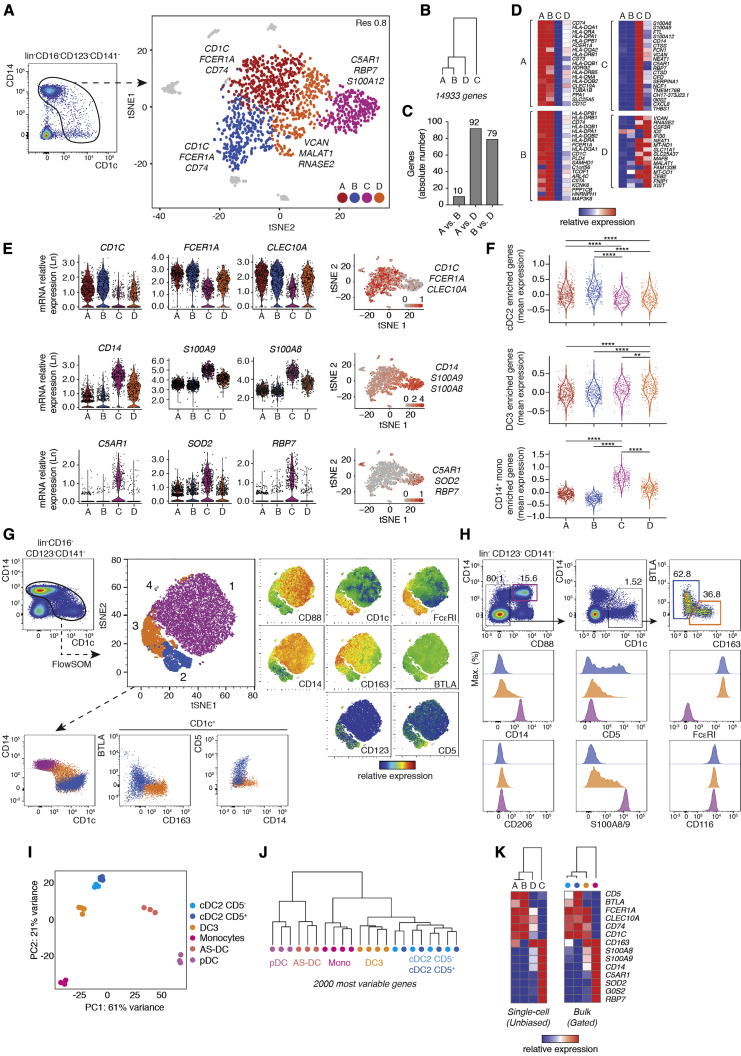
DC3s Are a Discrete Subset of CD88−CD1c+CD163+ Cells in Human Peripheral Blood(A) Gating strategy used to define mononuclear phagocytes expressing CD14 and/or CD1c. Cells expressing CD14 and/or CD1c were sorted by flow cytometry from 3 healthy donors and pooled before scRNA-seq analysis. To improve the resolution of CD1c+ subsets, the cellular input was enriched in CD1high cells (Figure S1A). Single cells were isolated using a droplet-based approach and sequenced. Dimensionality reduction of scRNA-seq data was performed using dimensionality reduction (t-distributed stochastic neighbor embedding [tSNE]). Clusters A, B, C, and D were identified using the shared nearest neighbor (SNN) clustering algorithm. Each dot represents an individual cell (n = 1,622).(B) Hierarchal clustering of groups A, B, C, and D based on average gene expression (14,933 genes).(C) Absolute number of differentially expressed genes (DEGs) for pairwise comparisons between groups A, B, and D.(D) Heatmaps displaying relative expression of up to 20 DEGs defining each cluster.(E) Violin plots illustrating expression probability distributions across clusters of representative DEGs (226 total DEGs). Feature plots display the average expression of groups of genes (identified in violin plots) in each cell of the tSNE plot defined in (A).(F) Expression distribution across clusters A, B, C, and D of gene signatures identified by Villani et al. (2017) and Yin et al. (2017). (∗∗p < 0.01, ∗∗∗∗p < 0.0001, one-way ANOVA test)(G) Identification of 4 subsets within CD14lo to hi CD1clo to hi cells by unsupervised clustering of flow cytometry data using the FlowSOM algorithm. tSNE and unsupervised clustering were performed using the following markers: CD88, CD1c, FcεRI, CD14, CD163, BTLA, CD123, and CD5. tSNE plots (right) display the relative expression of each marker among the subsets. Dot plots (below) show the expression of specific markers in clusters 1, 2, and 3 when combined in 2-dimensional analysis.(H) Improved gating strategy for identification of cDC2s, DC3s, and CD14+ monocytes in circulating PBMCs and histograms showing expression of S100A8/9, FcεRI, CD5, CD14, CD116, and CD206.(I) Principal-component analysis (PCA) for bulk-sequenced mononuclear phagocyte populations as defined in (H).(J) Cluster dendrogram of the different cell types using the 2,000 most variable genes.(K) Heatmaps comparing the relative expression of markers discriminating clusters in scRNA-seq analysis (A, B, C, and D, left) and in bulk RNA-seq analysis on sorted subsets based on the gating strategy defined in (H) (right).See also Figure S1 and Table S1.